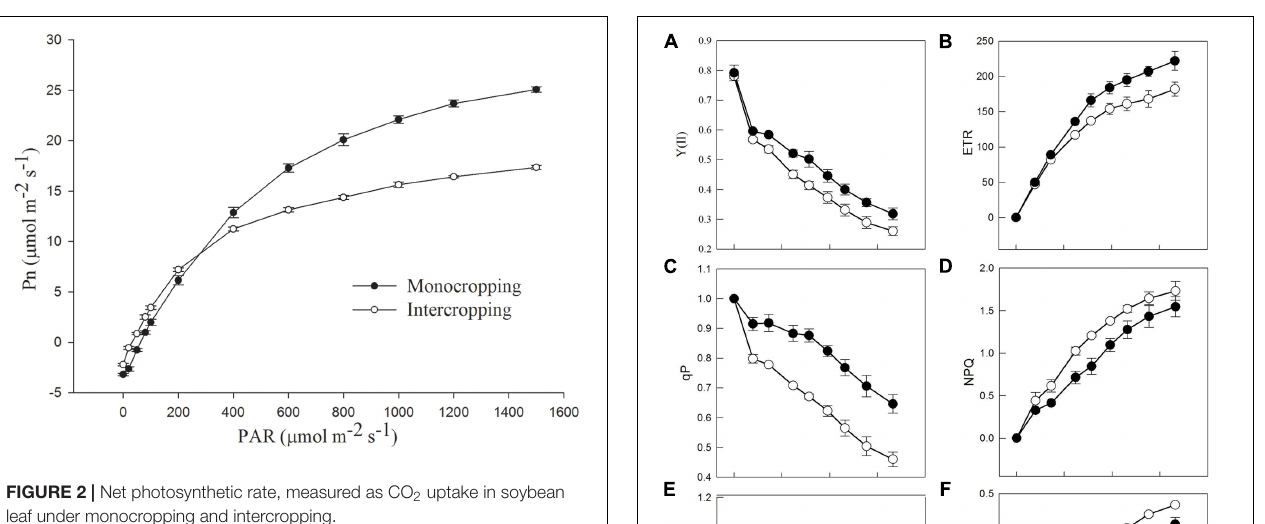
TABLE 2 | Effect of shade on the photosynthetic parameters of soybean leaves. Treatment